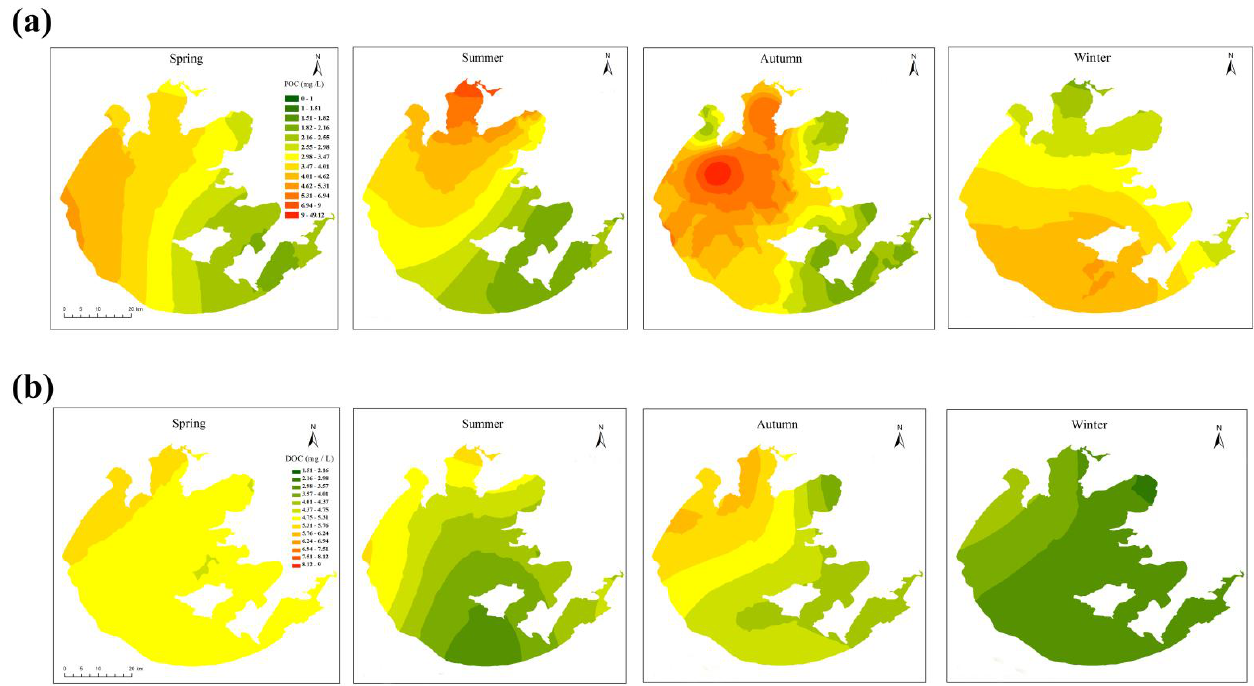
Figure 6. Spatial distribution of particulate organic carbon (POC) ( a ) and dissolved organic carbon (DOC) ( b ) during four seasons in Lake Taihu.